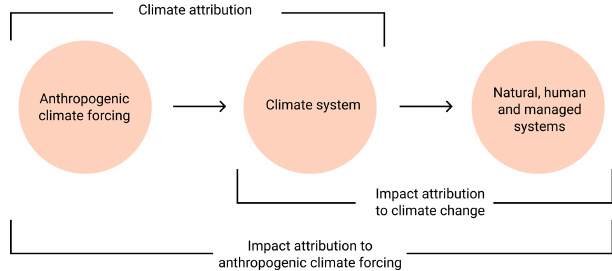
Figure 1. Differences between drivers and affected systems in attri- bution research. Climate attribution (first arrow) is a focus of IPCC WGI (IPCC, 2013), and (climate) impact attribution is a focus of IPCC WGII (IPCC, 2014, chap. 18). The methodology and data presented here facilitate the use of (process-based) impact models to attribute observed changes in human, managed and natural sys- tems to climate change (second arrow). The additional step of attri- bution to anthropogenic climate forcing (first and second arrow) is not addressed